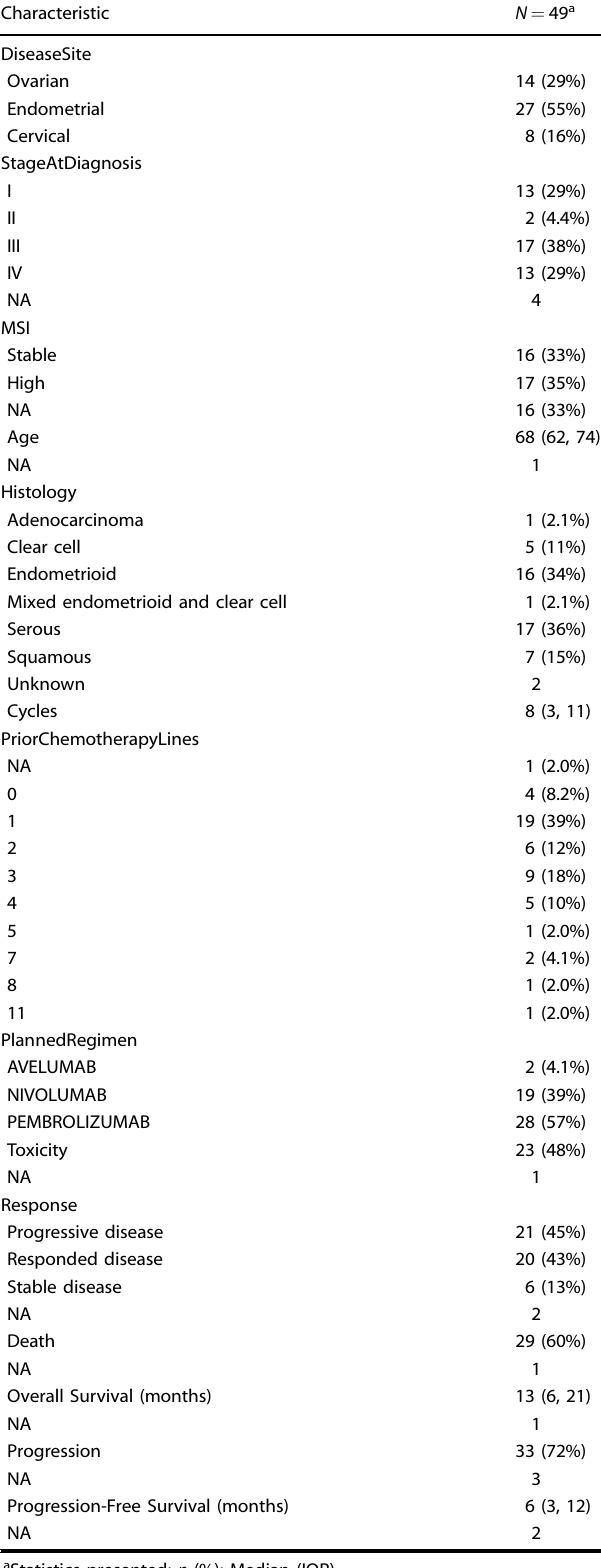
Table 1. Clinico-pathological summaries of 49 gynecology patients included in this